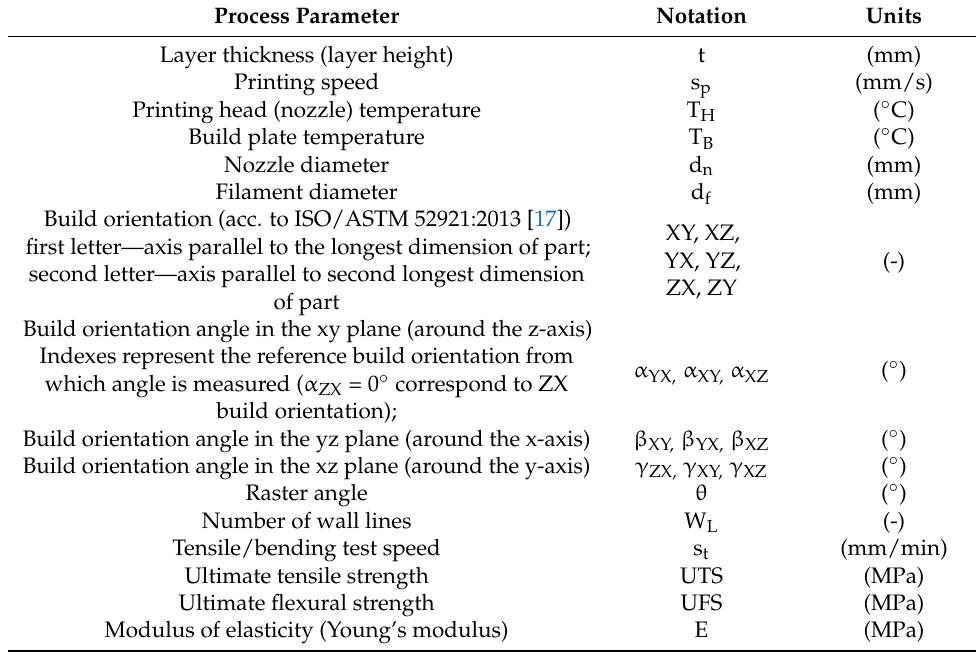
Table 1. Notations and